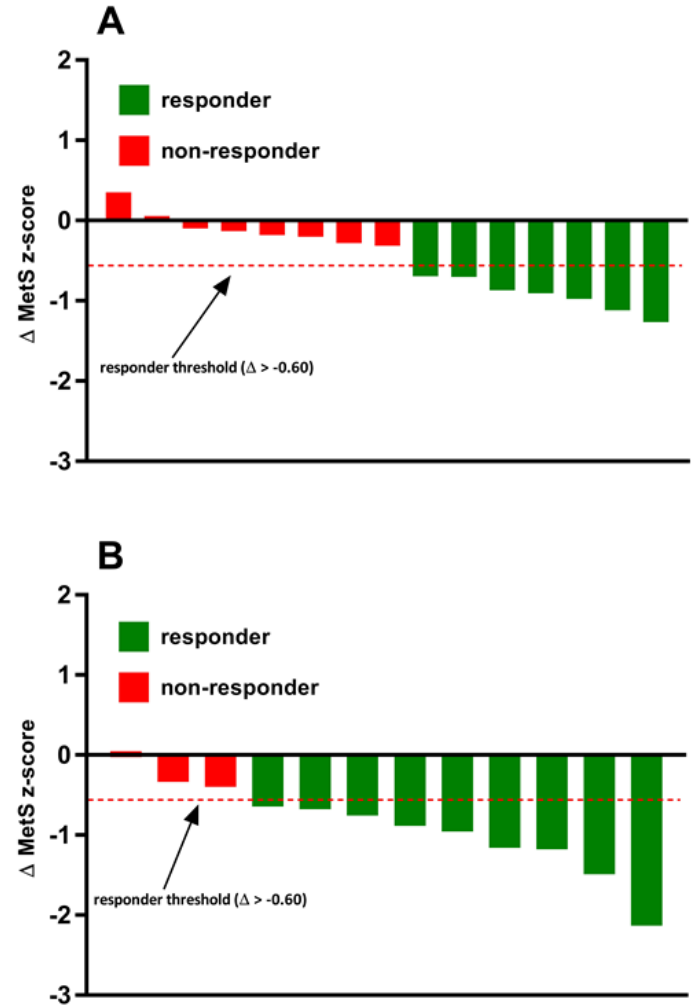
Figure 2. Inter-individual variability in the MetS z-score responses to exercise training in the ( A ) MICT group and ( B ) REHIT